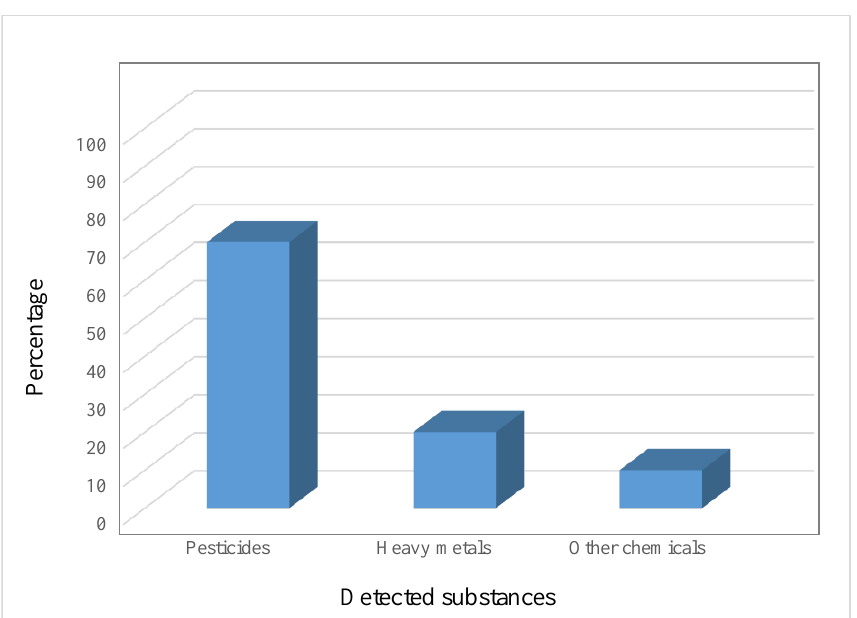
Figure 4. Applications of enzymatic biosensors. (Data from